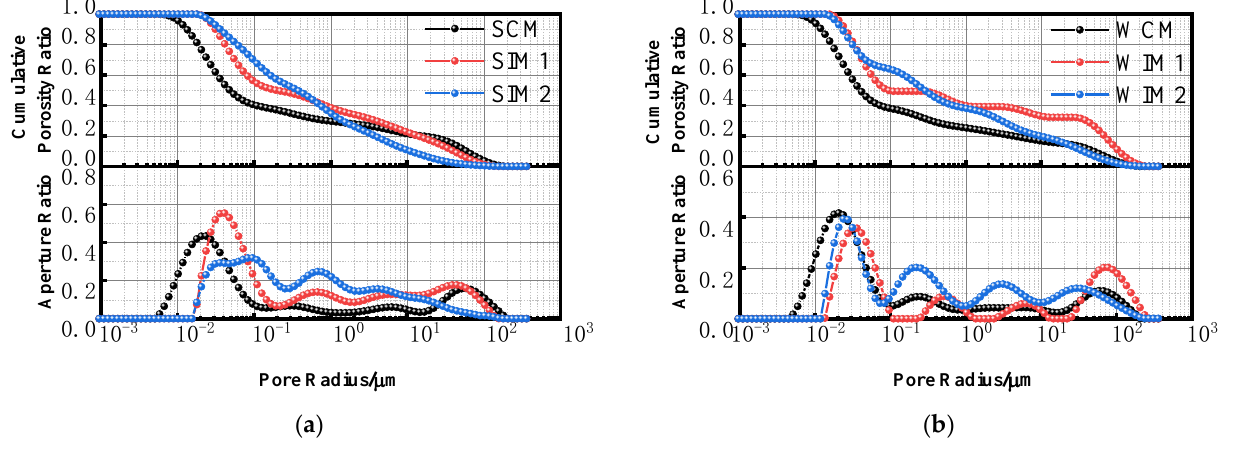
Figure 15. Specimen pore size distribution curve: ( a ) 7 d; ( b ) 28 d. Table 7. Aperture distribution (unit: µ